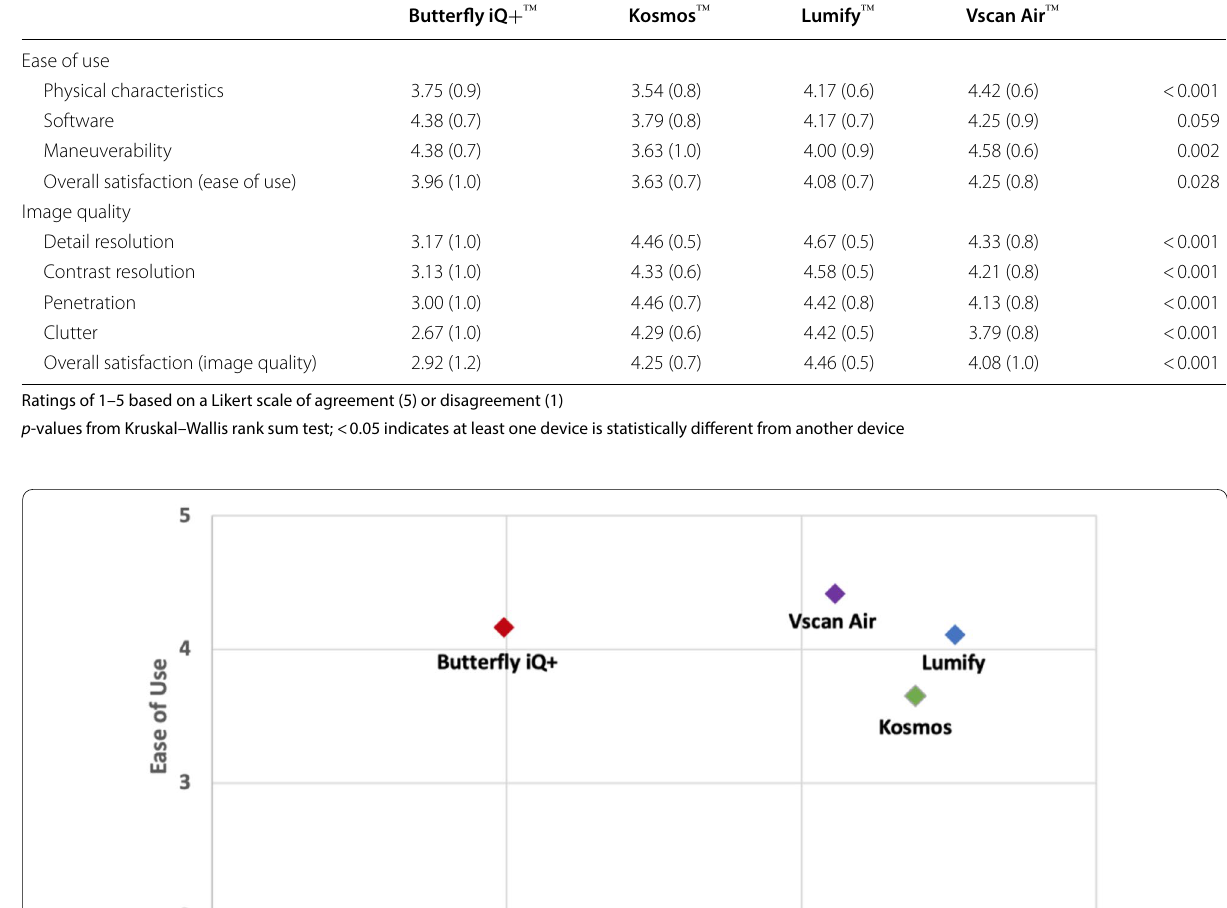
Table 2 Ratings of handheld ultrasound devices per point‑of‑care ultrasound experts